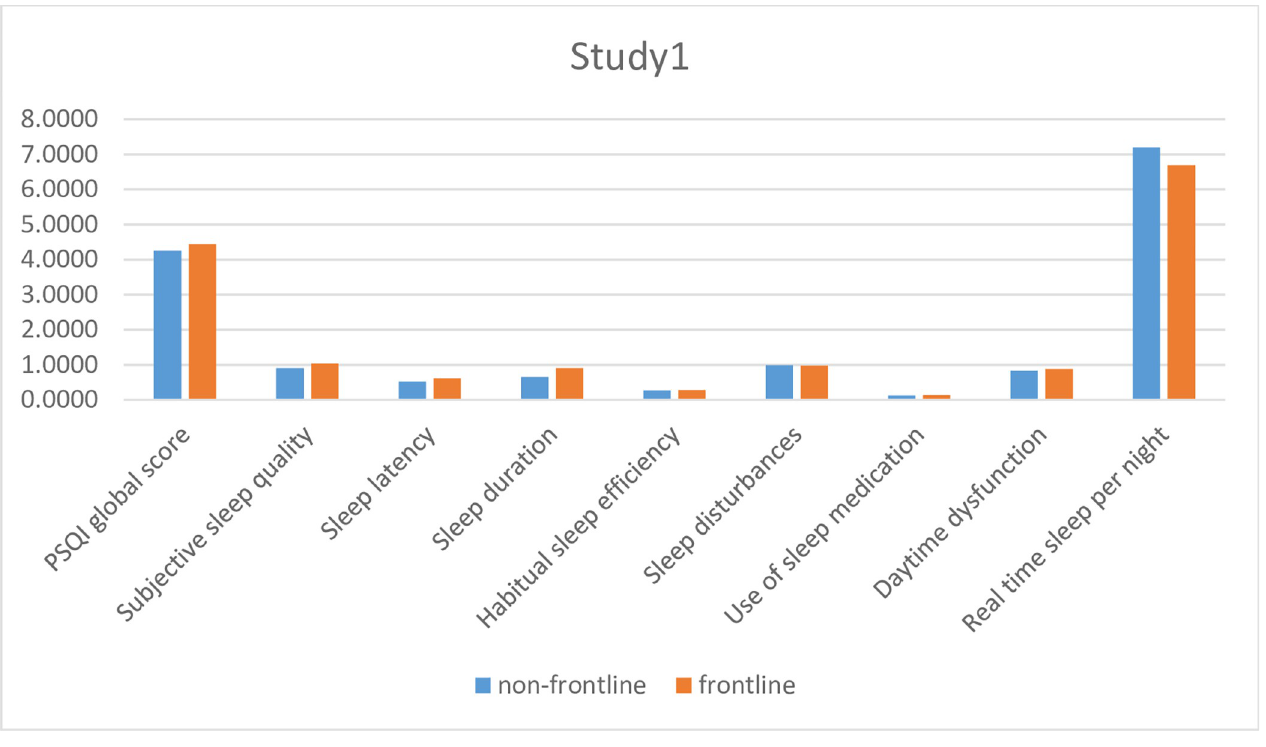
Fig 3. Individual components of PSQI in